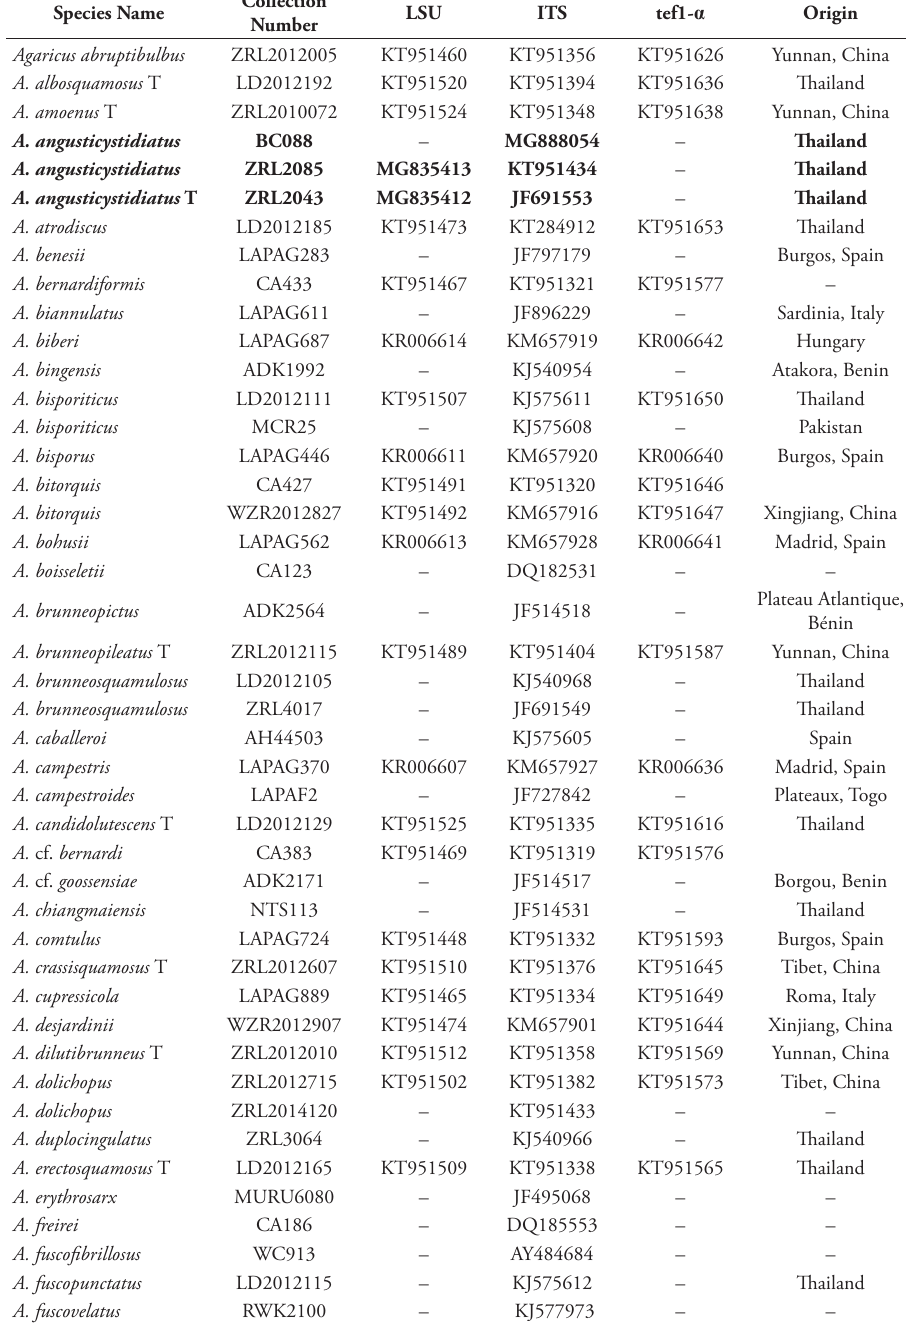
Table 1. Taxa information used in the phylogenetic analyses, new taxa are in bold, “T” refers to